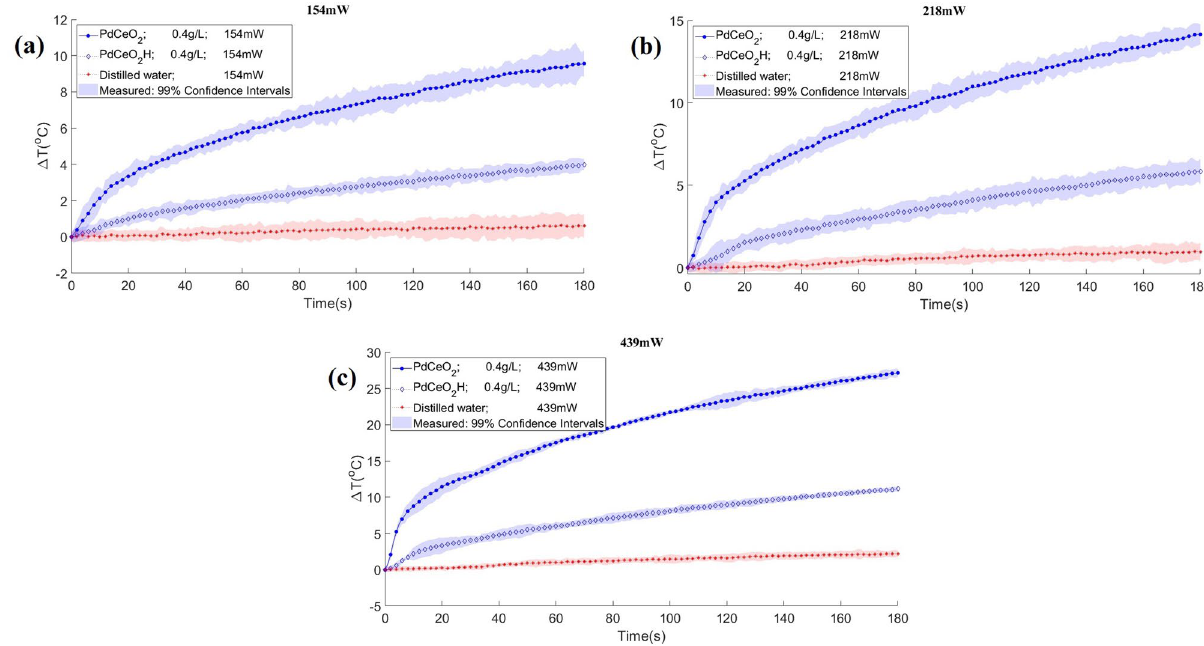
Figure 4. Experimental temperature variation of nano Pd cerium oxide, PdCeO 2 (filled circle) and nano Pd hydride cerium oxide, PdCeO 2 H (filled diamond) nanofluids with a concentration of 0.4 g/L. Heating performed during 3 min with three powers: ( a ) 154 mW, ( b ) 218 mW and ( c ) 439 mW. Distilled water (red) was used as